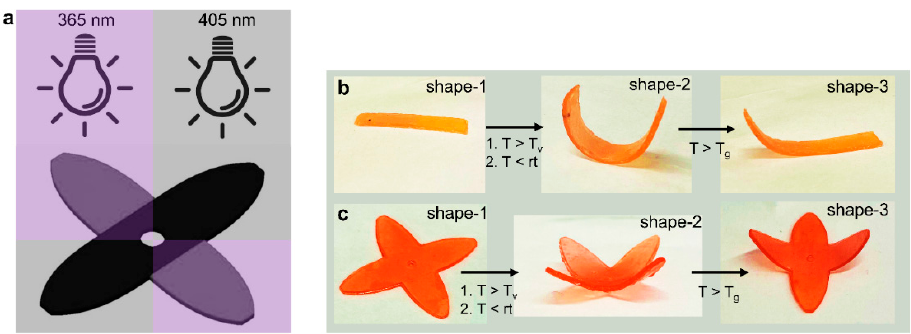
Figure 44. ( a ) Illustrations of the printing setup of the rectangular bar and grippers; ( b ) the permanent, programming, and spatially-controlled shaping experiment; and ( c ) the permanent, programming, and spatially-controlled state of the multi-material gripper under thermal stimuli. Reproduced from Ref. [237] with permission from the Royal Society of Chemistry.